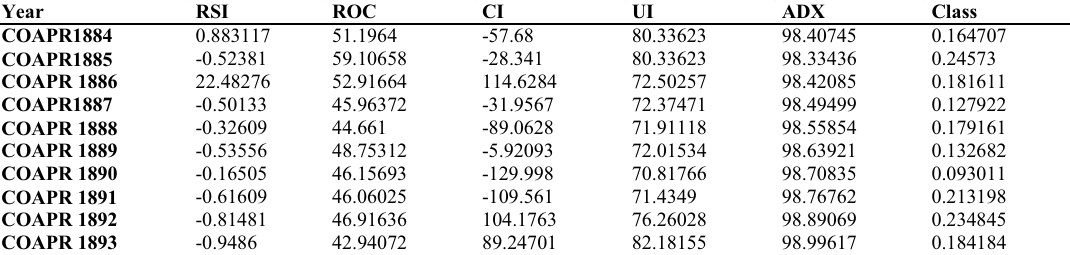
Table 1. Sample results after converting data with feature indicators (dataset1)